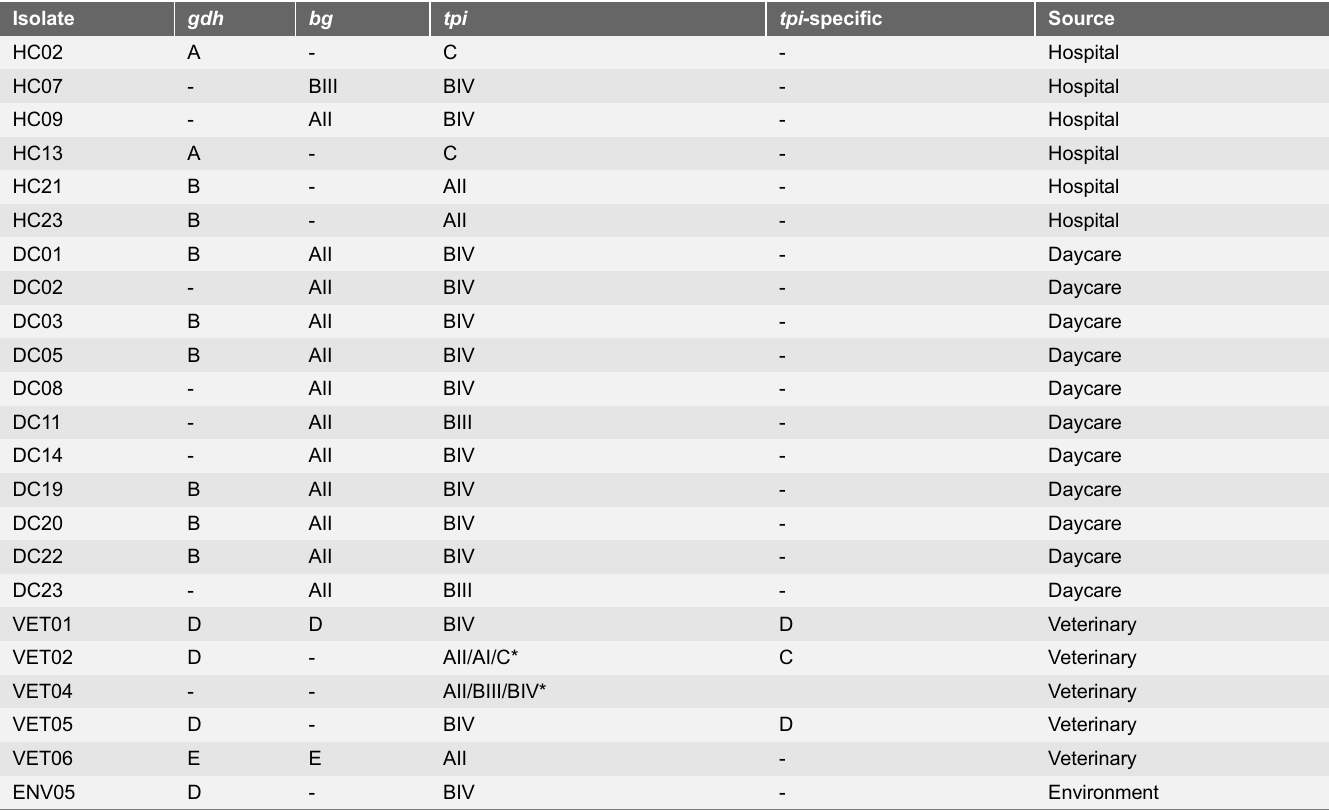
Table 2. Molecular characterization of isolates presenting mixed assemblage infections.